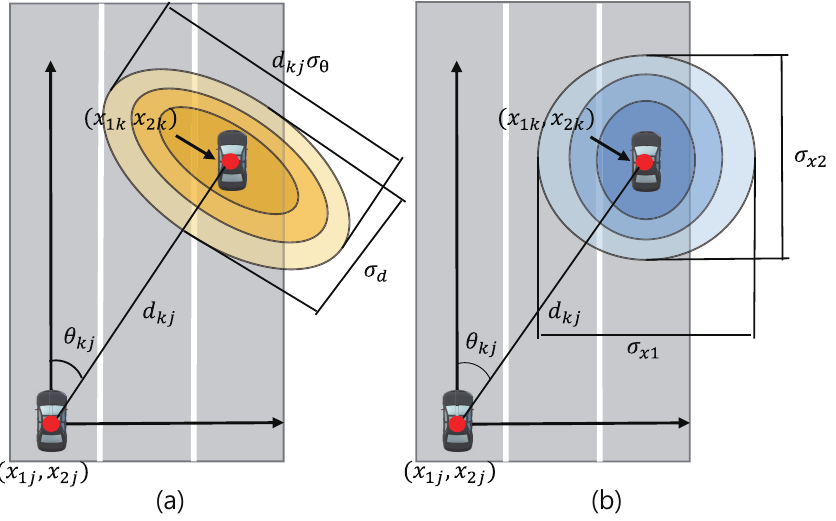
Figure 2. Measurement models: ( a ) original model ( b ) modified